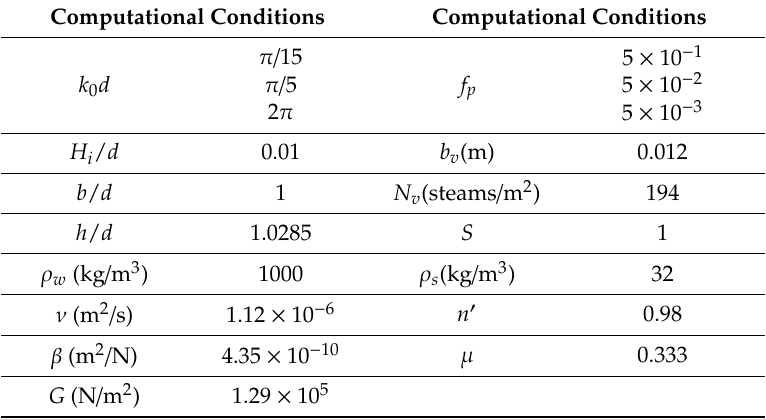
Figure 1. Comparison of the reflection and transmission coefficients versus the number of adopted evanescent wave modes. Table 1. Computational conditions for the verification of the number of adopted evanescent modes of the proposed solution.